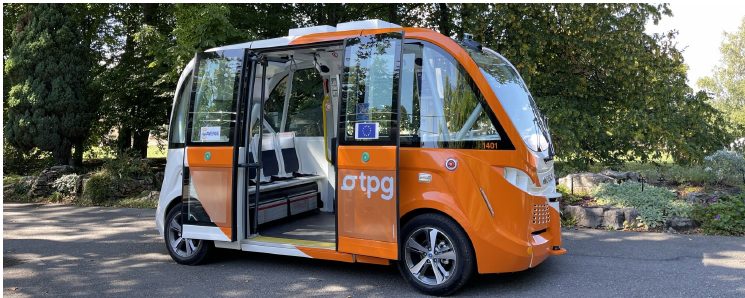
Figure 1. Example of an automated city shuttle (Geneva,